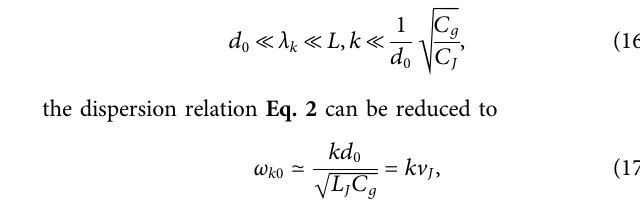
Figure 2C,D represent the single-photon transmittance and the frequency conversion rate, respectively, of the giant atom in the Markovian